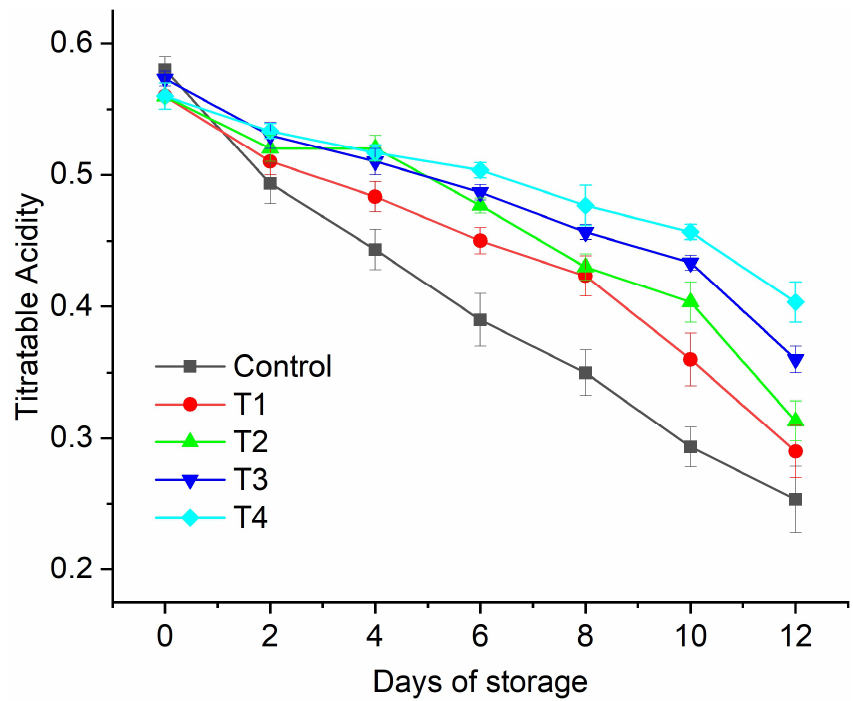
Figure 4. Effect of edible coatings on titratable acidity of Ficus carica fruit: uncoated control (water-washed), AVG (T1), AVG + glycerol (T2), AVG + glycerol + anthocyanin + 0.2% (T3), AVG + glycerol + anthocyanin + 0.5% (T4). Data are presented as mean ± SD, ( n = 3).